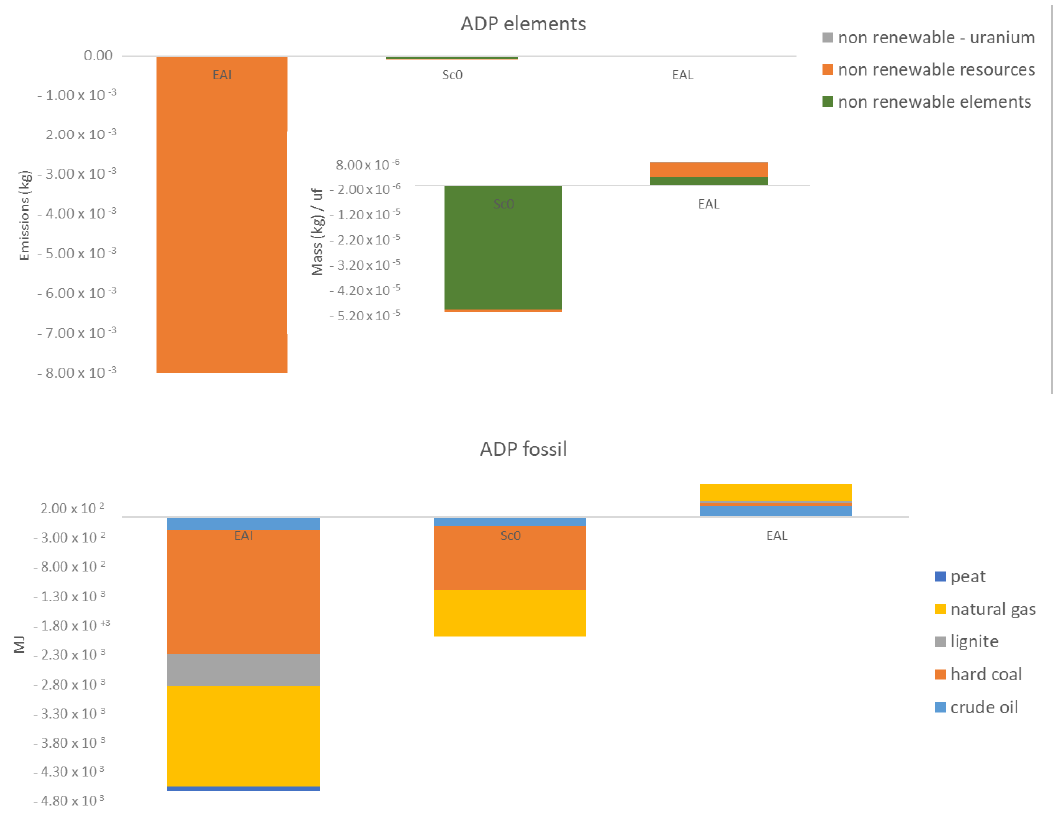
Figure 7. Abiotic depletion potential comparison for the reference case (Sc0) among average European scenarios. Top —abiotic depletion of elements, insights for Sc0 and EAL scenarios; bottom —abiotic depletion of fossil resources. Results refer to one tonne of treated residues.